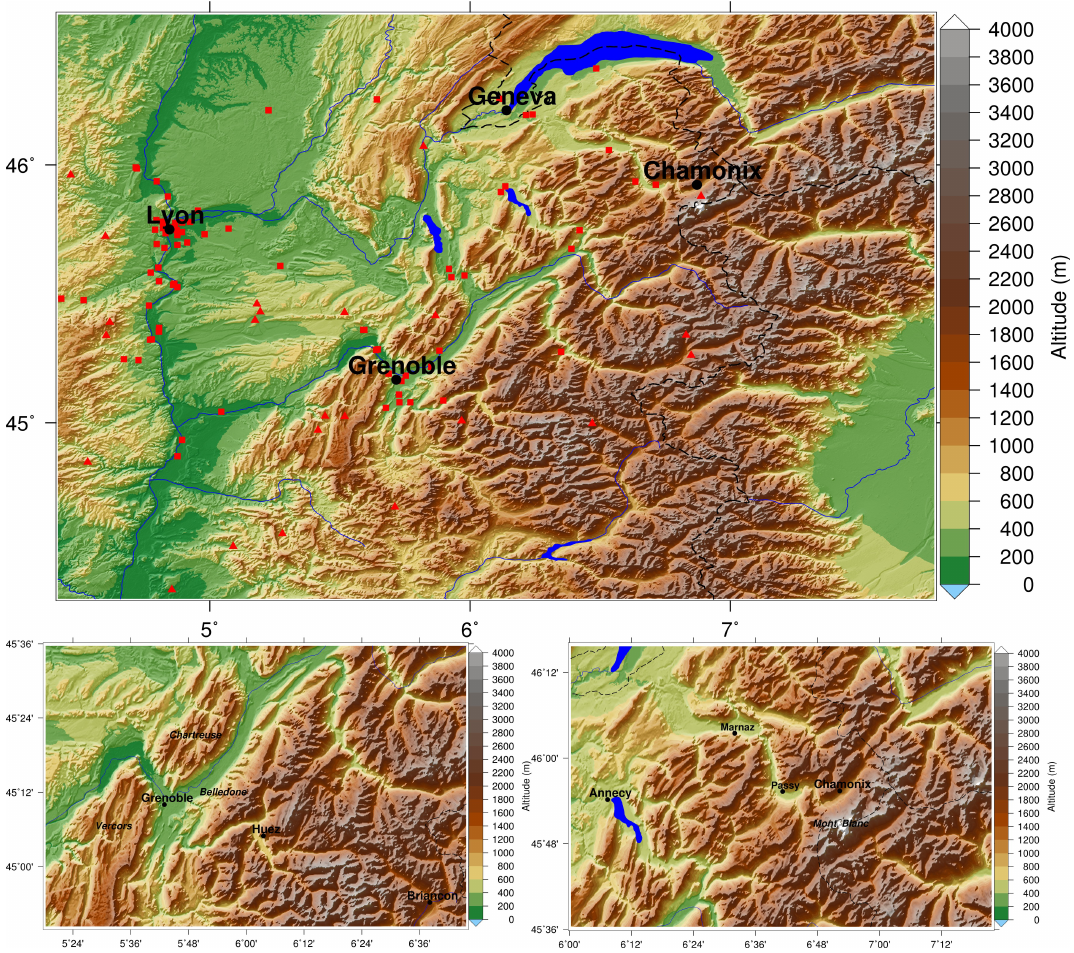
Figure 1. The target domains over the Alps (top, ALP0033), Grenoble (bottom left, GRE0011) and Arve Valley (bottom right, ARV0011). Red triangle and square symbols are respectively the locations of rural and urban air quality monitoring sites used for the evaluation. Dark blue color is used for water bodies. Maps generated with the Generic Mapping Tools,